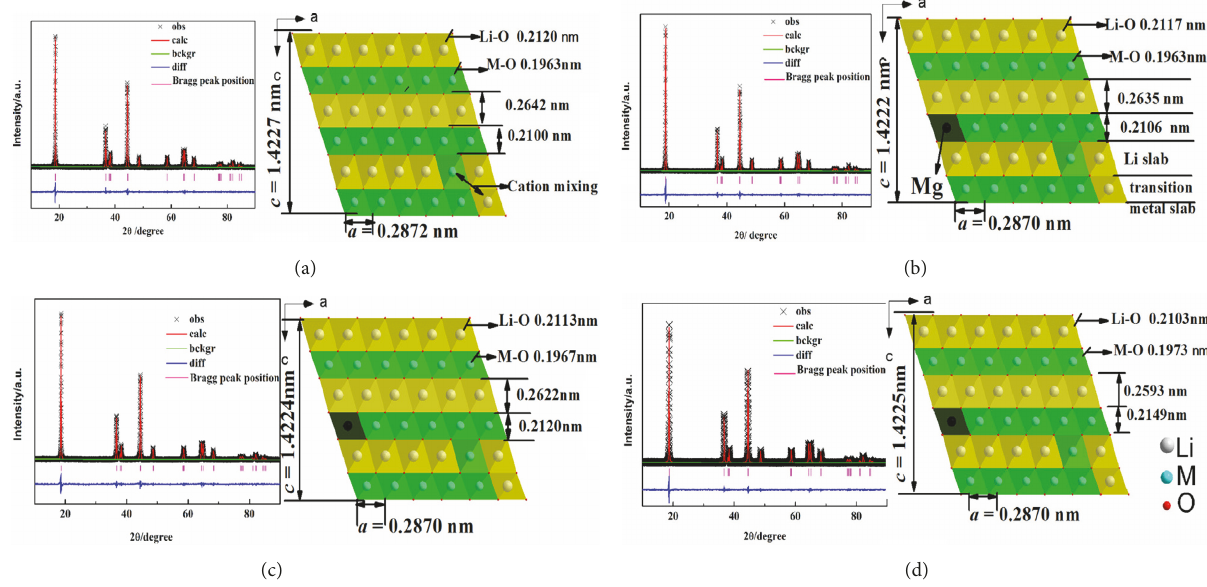
Figure 8: Rietveld refinement results for the prepared samples: (a) Mg-0, (b) Mg-1, (c) Mg-3, and (d) Mg-5 [48]. Copyright: Electrochimica Acta,